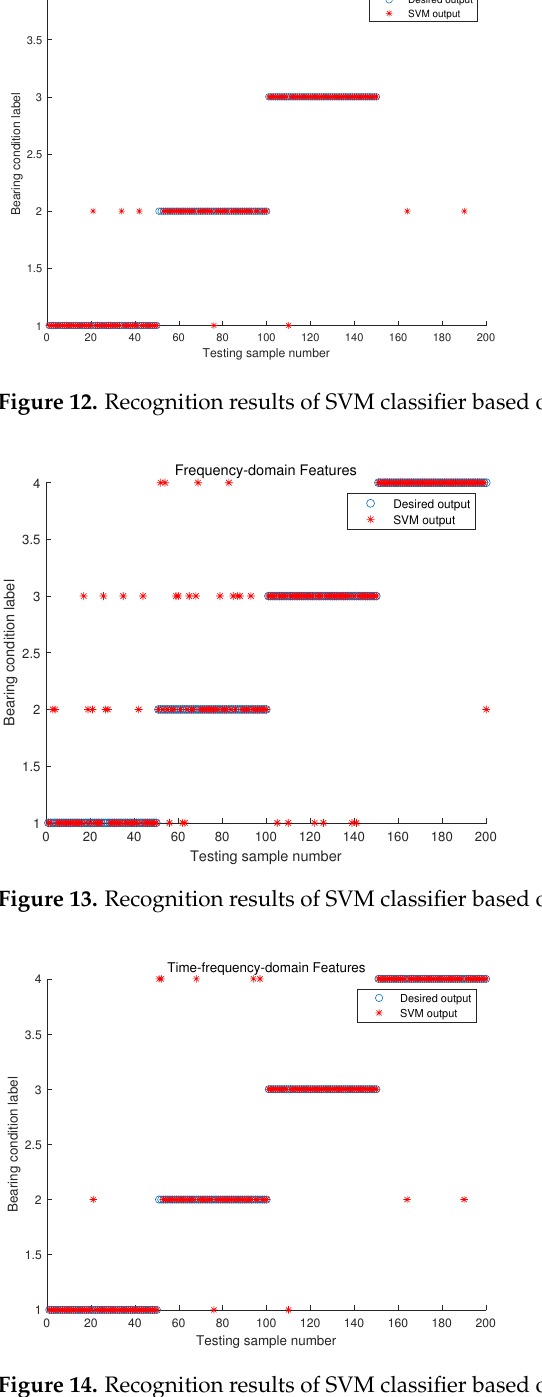
Figure 14. Recognition results of SVM classifier based on T-F